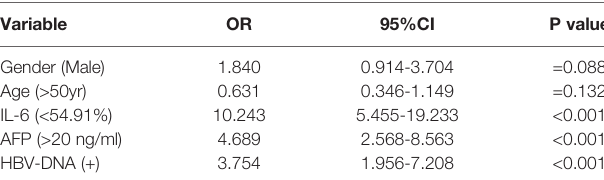
TABLE 5 | Independent risk factors for development of